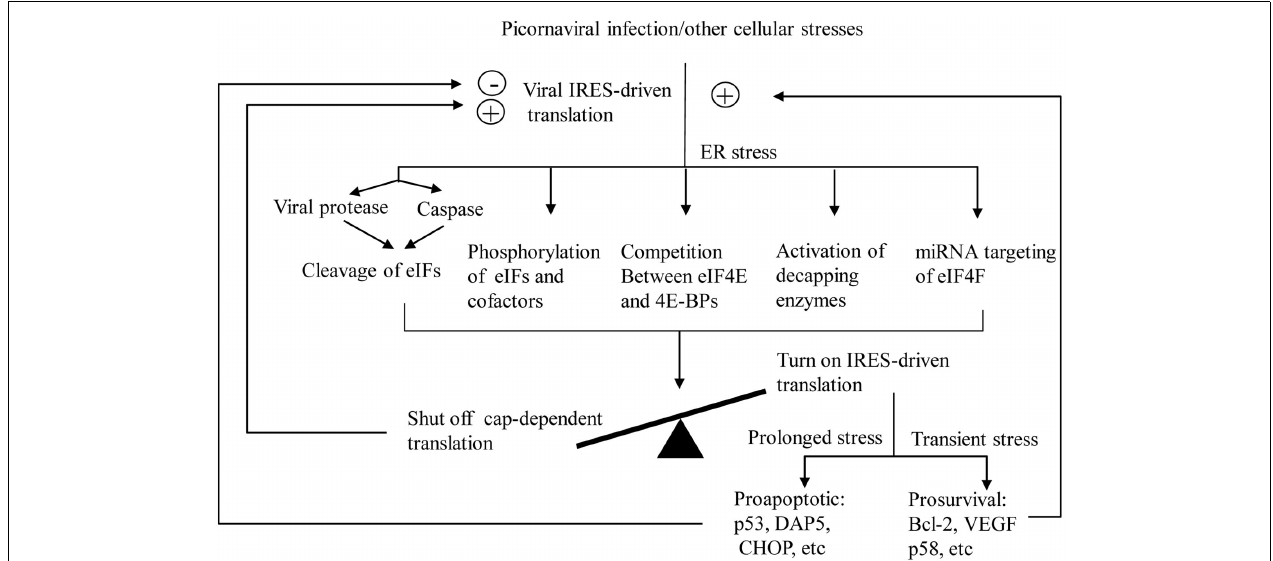
FIGURE 2 |The proposed model for the switch of translation initiation from cap-dependent to IRES-dependent during picornaviral infection or other cellular stresses. Positive and negative feedback loops are indicated by plus and minus signs, respectively.